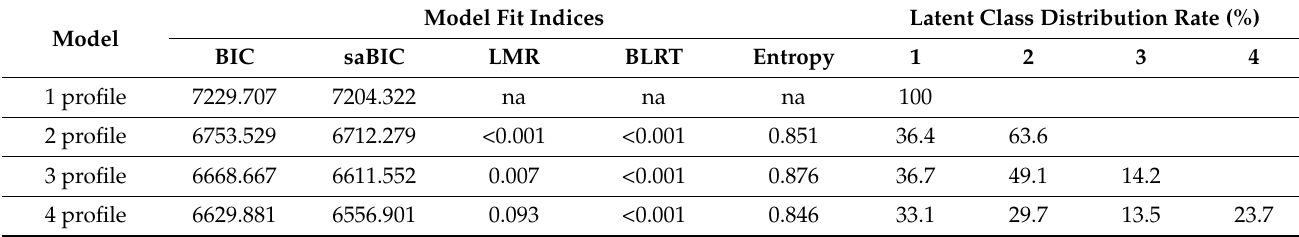
Table 2. Model Fit Indices of Latent Profile Analysis and Distribution Rate of Problem list ( N = 401).